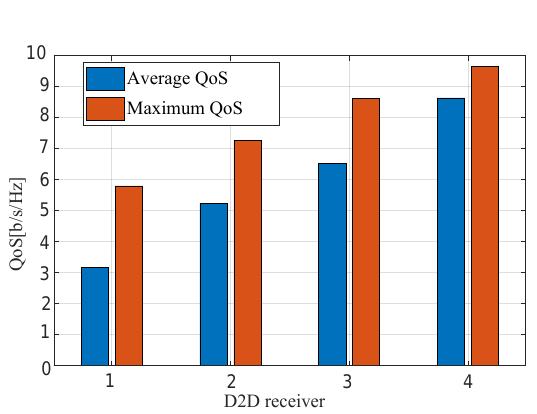
Figure 3. Average QoS and Maximum QoS of D2D receivers cell, 2 cellular users in each pico cell, and 2